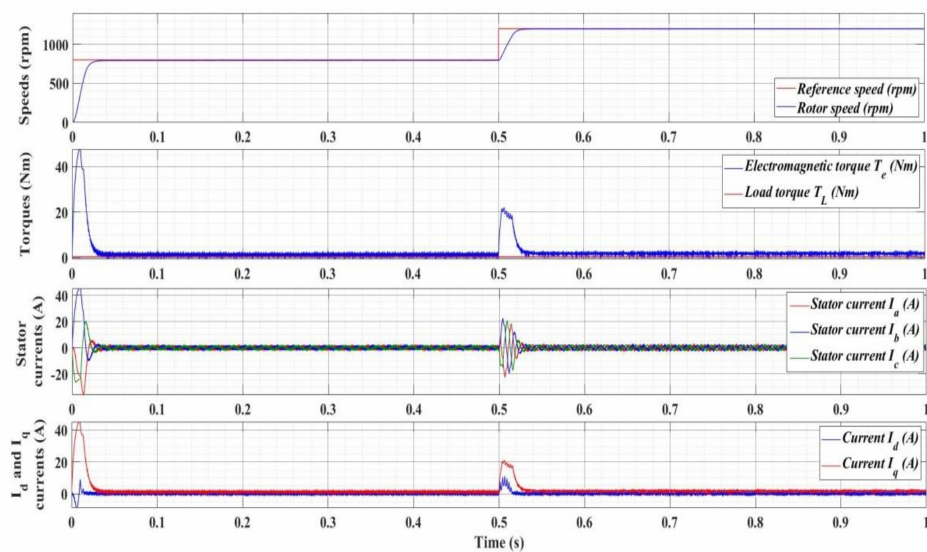
Figure 29. Time evolution for the numerical simulation of the PMSM control system based on the RL-TD3 agent for the correction of i qref .